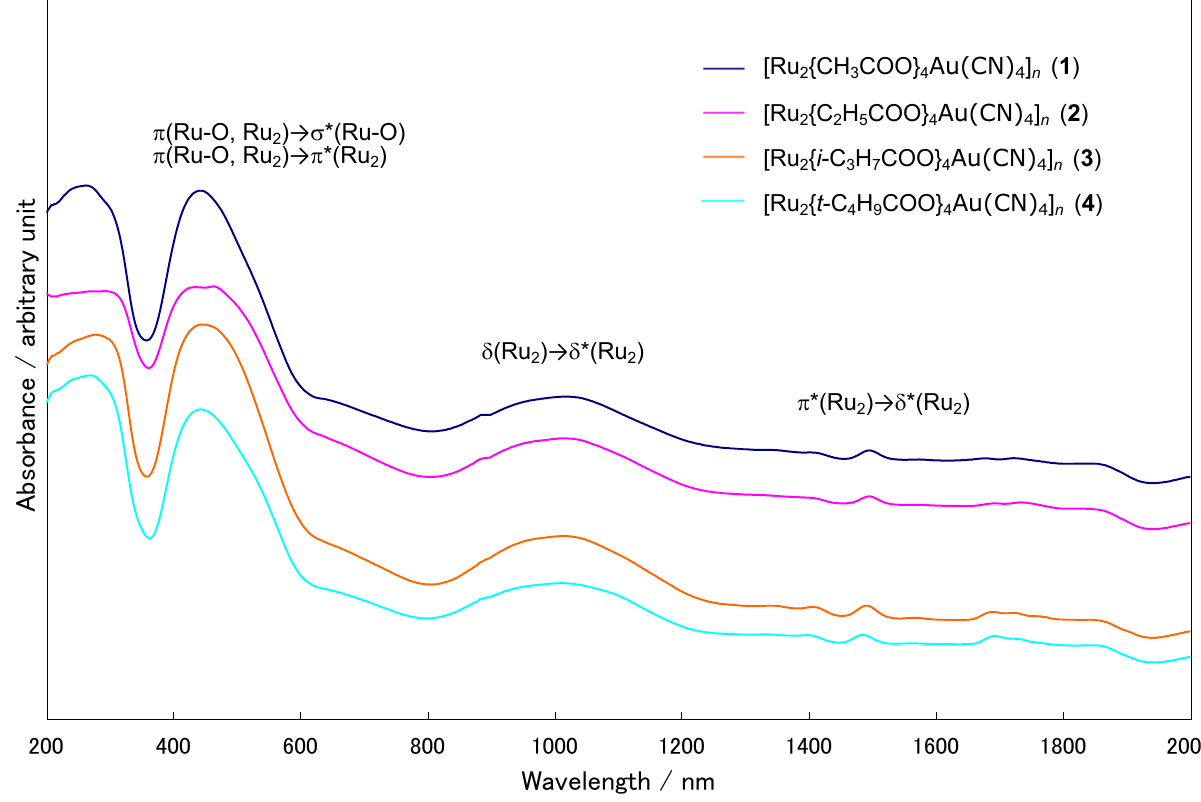
Figure 2. Diffused reflectance spectra of [Ru 2 (CH 3 COO) 4 Au(CN) 4 ] n ( 1 ) (dark-blue line), [Ru 2 (C 2 H 5 COO) 4 Au(CN) 4 ] n ( 2 ) (pink line), [Ru 2 ( i -C 3 H 7 COO) 4 Au(CN) 4 ] n ( 3 ) (orange line), and [Ru 2 ( t -C 4 H 9 COO) 4 Au(CN) 4 ] n ( 4 ) (right-blue line).